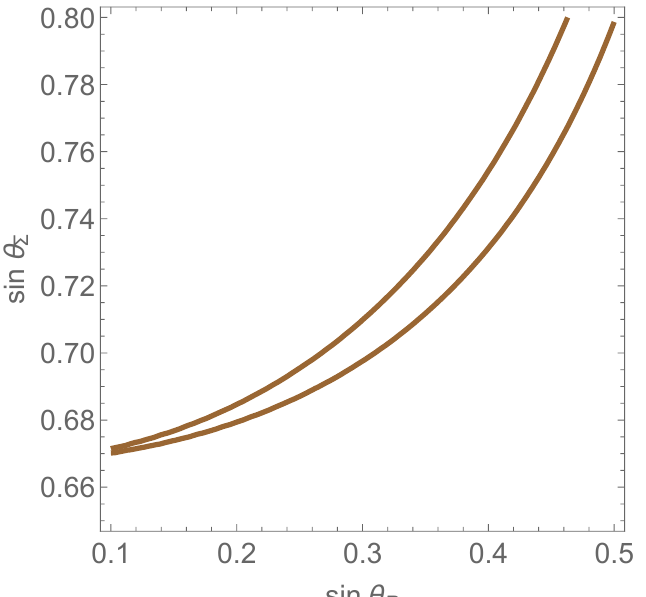
for L (cid:28) R (cid:28) R